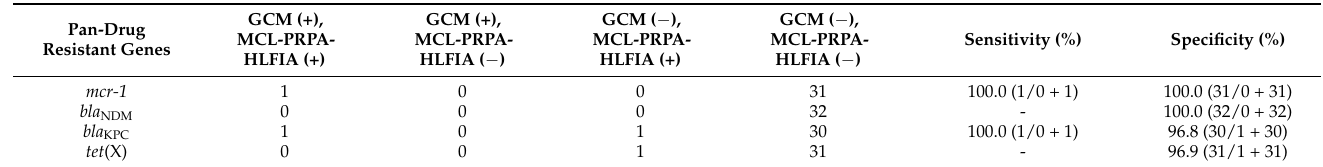
Table 2. Detection system sensitivity and specificity for detecting pan-drug-resistant genes in the actual UTI